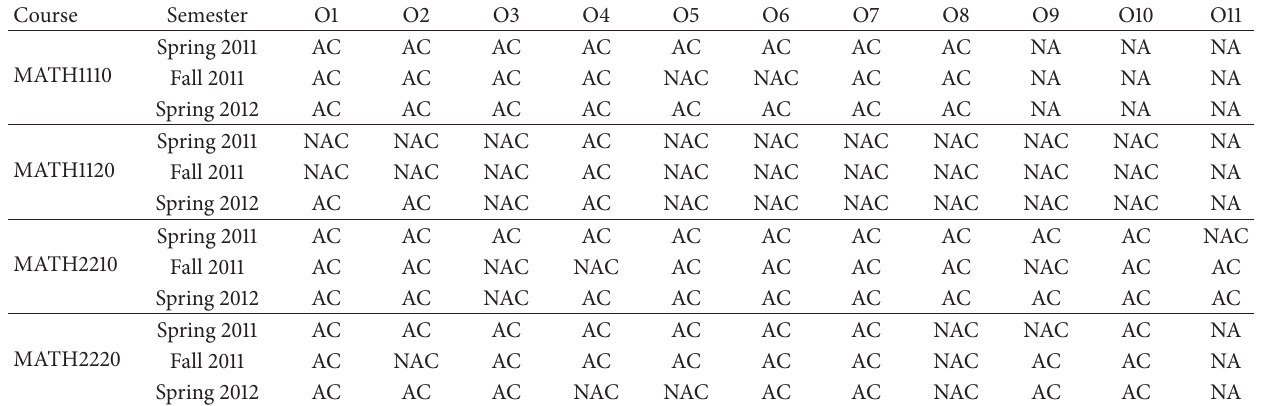
Table 10: Judgment on outcomes achievement based on adopted criteria for directly assessment outcomes (AC: achieved, NAC: not achieved, and NA: not